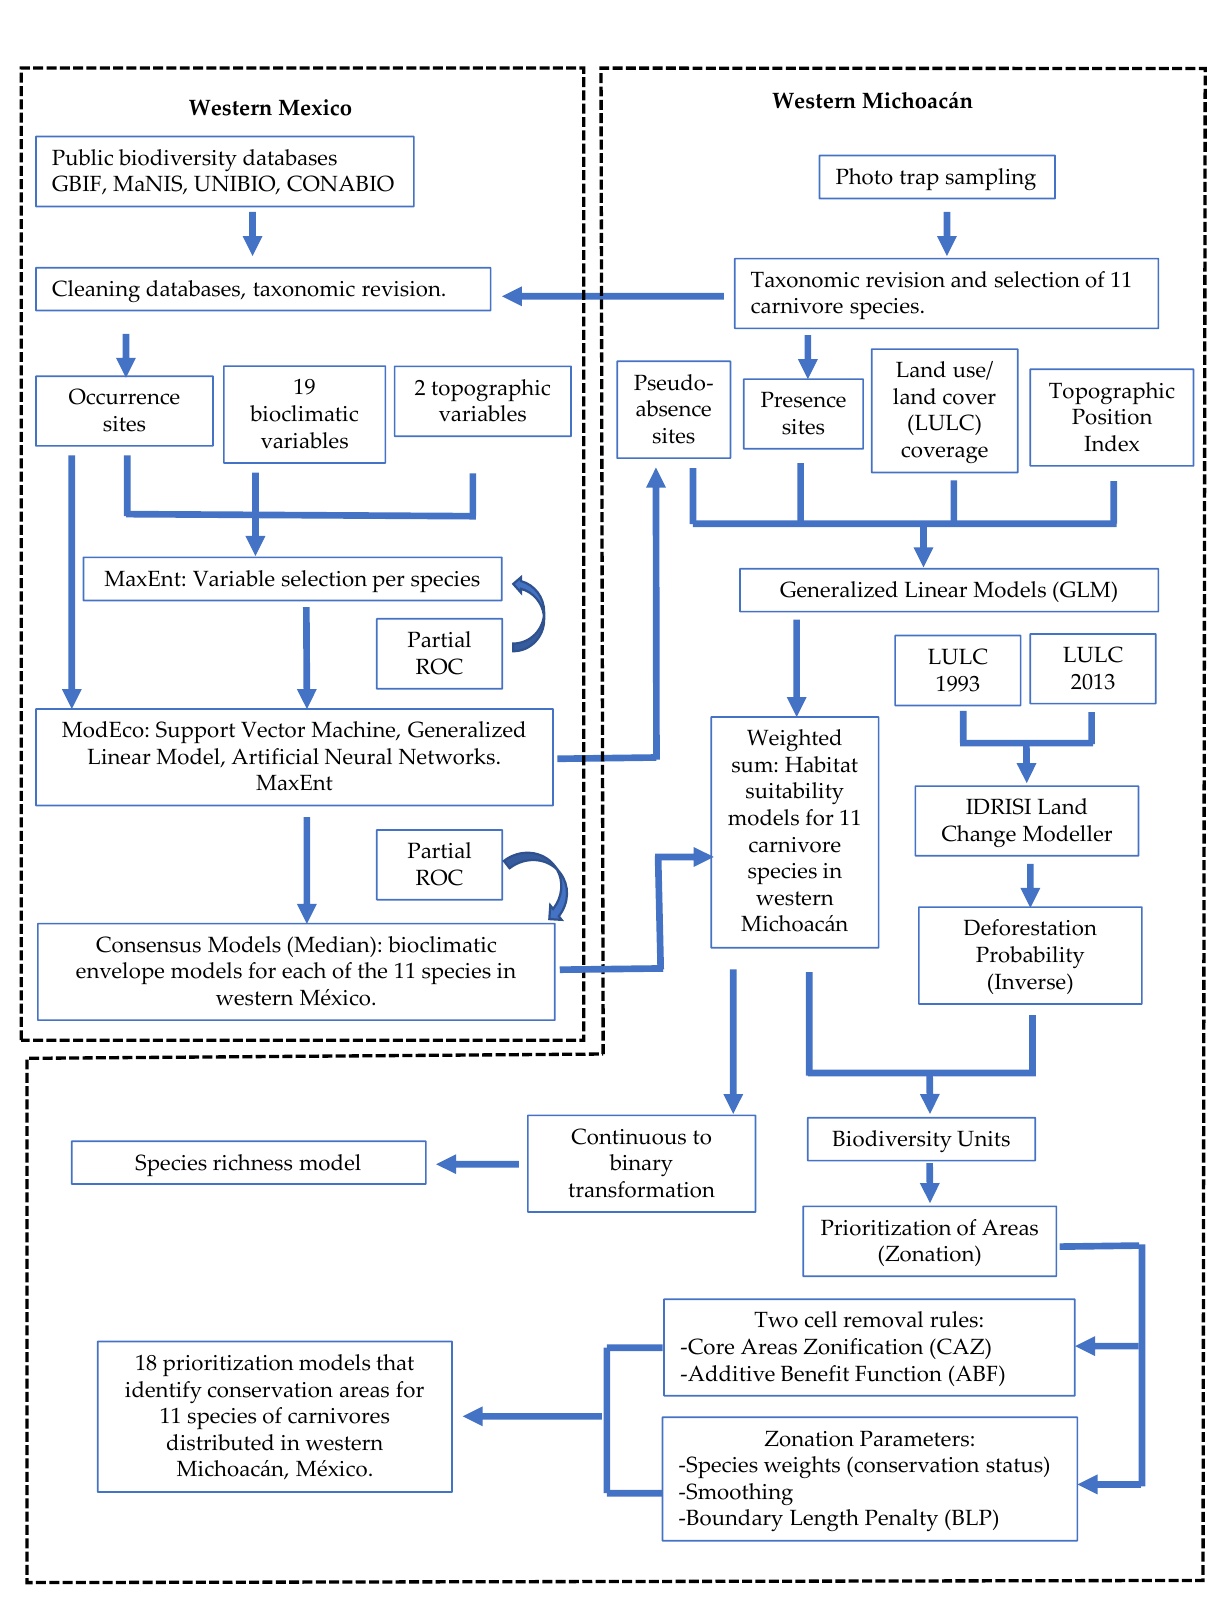
Figure 3. Flow diagram of the methods used. Dash lines separate two paths (scales), while boxes indicate the steps and obtained models.